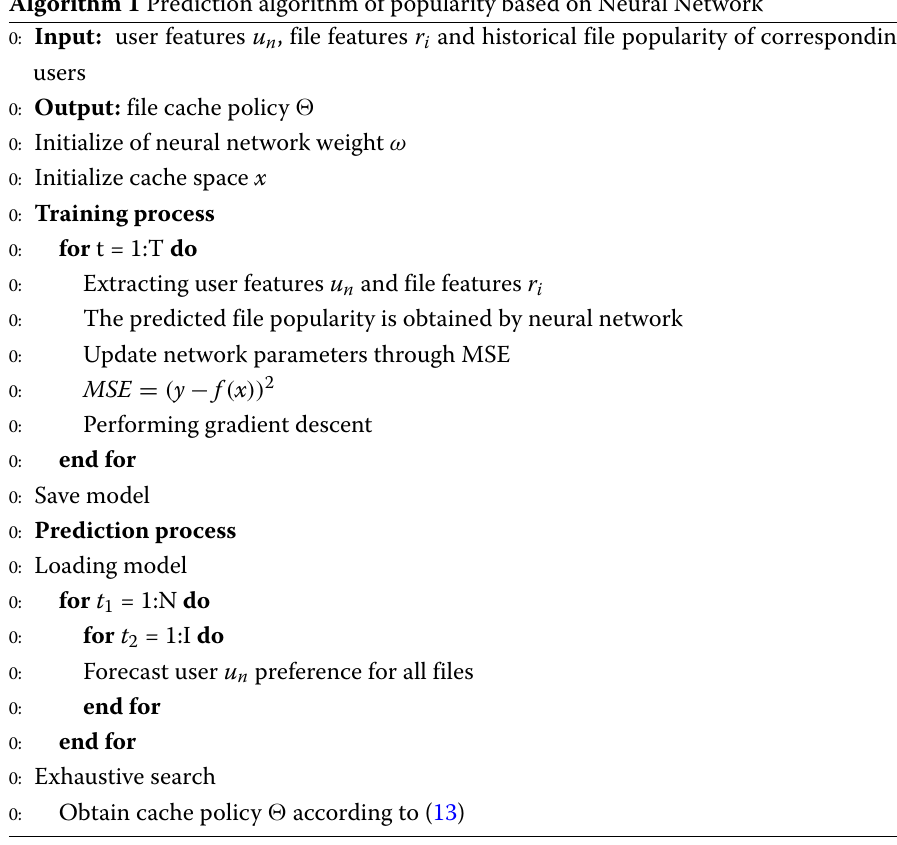
Algorithm 1 Prediction algorithm of popularity based on Neural